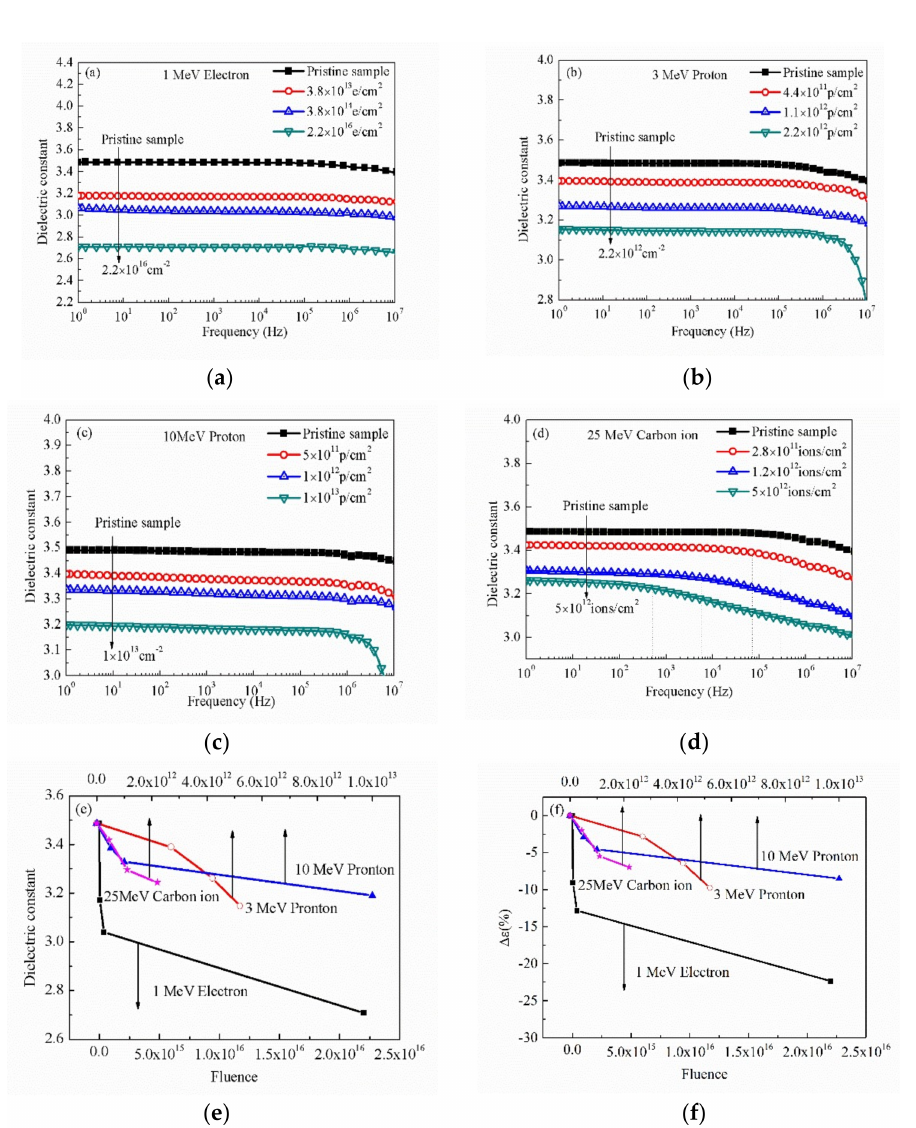
Figure 1. Frequency dependent dielectric constant of pristine and irradiated polyimide (PI) films with di ff erent sources and fluences at room temperature: ( a ) 1 MeV electron, ( b ) 3 MeV proton, ( c ) 10 MeV proton, ( d ) 25 MeV carbon ion, ( e ) dielectric constant at 100 Hz, and ( f ) the rate of change of dielectric constant at 100